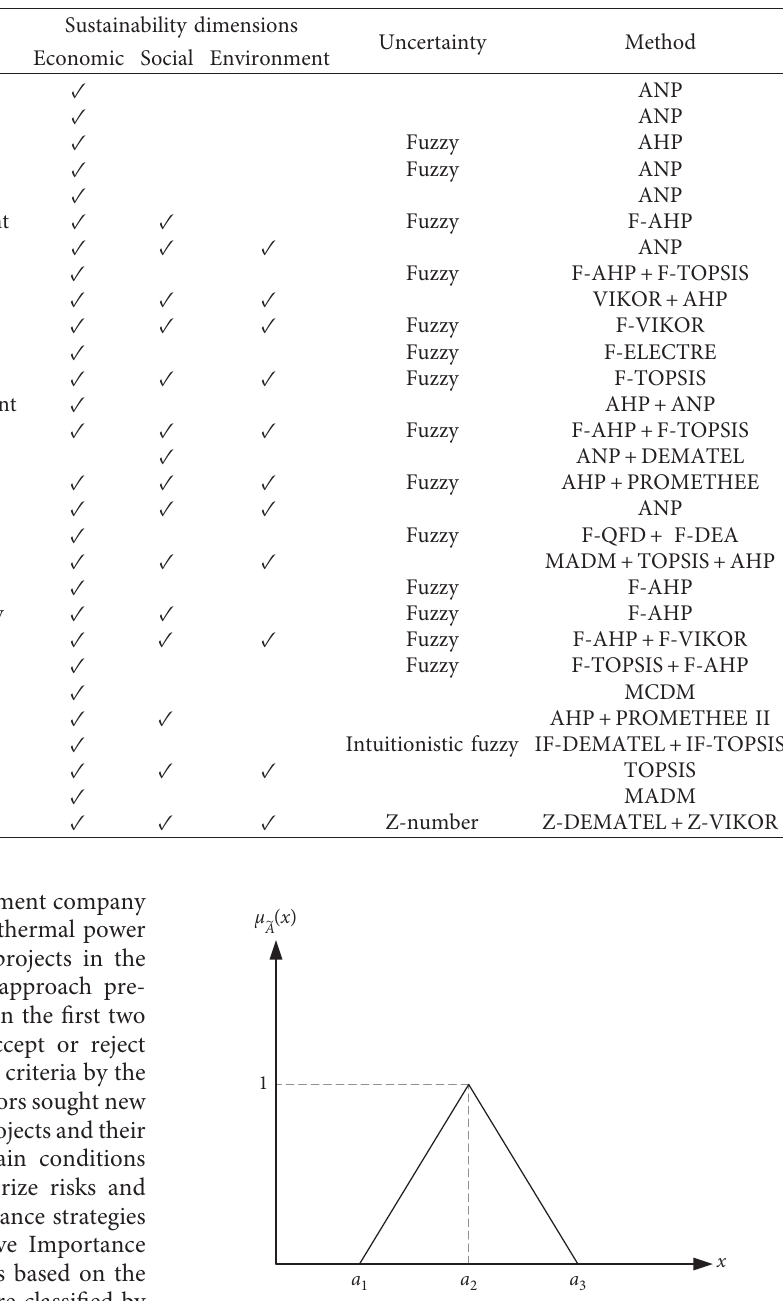
Table 1: Summary of previous articles.